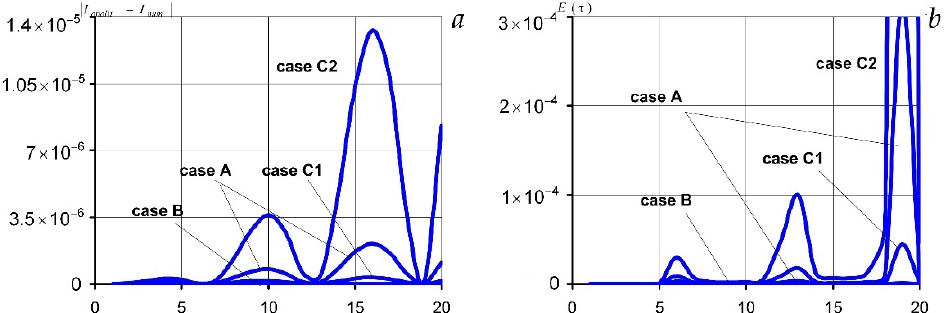
Figure 11. Graphs of absolute ( a ) and relative ( b ) errors for four considered cases of A, B, C1, and C2 of the relation between the number of nodes and grid width for the integrand f ( τ (cid:48) , τ (cid:48)(cid:48) ) = sin( τ (cid:48) )sin( τ (cid:48)(cid:48) ).